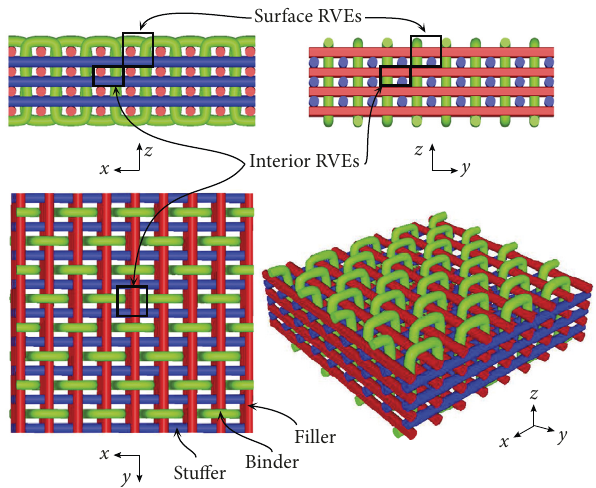
Figure 2: A noobed fabric seen from its three principal planes and in an isometric view. Surface and interior RVEs are also outlined.